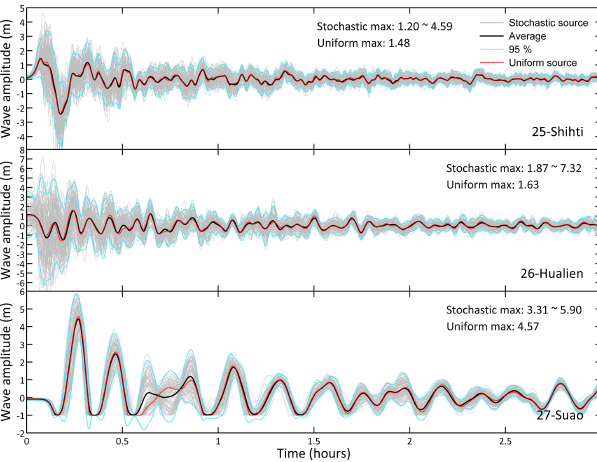
Figure 4. The time series of the wave heights recorded at stations 25 (Shihti), 26 (Hualien) and 27 (Suao). Gray lines represent the time series of 100 different slip distributions, black lines represent the averages of the gray lines, blue lines represent the 95% confidence intervals, and red lines are the time series produced using uniform slip distribution. Parts of the wave heights at station 27 are lower than the water depths, and thus, these curves have been